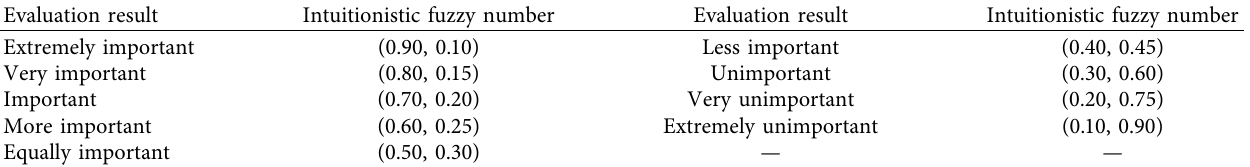
Table 4: The relationship between the evaluation results and the intuitionistic fuzzy